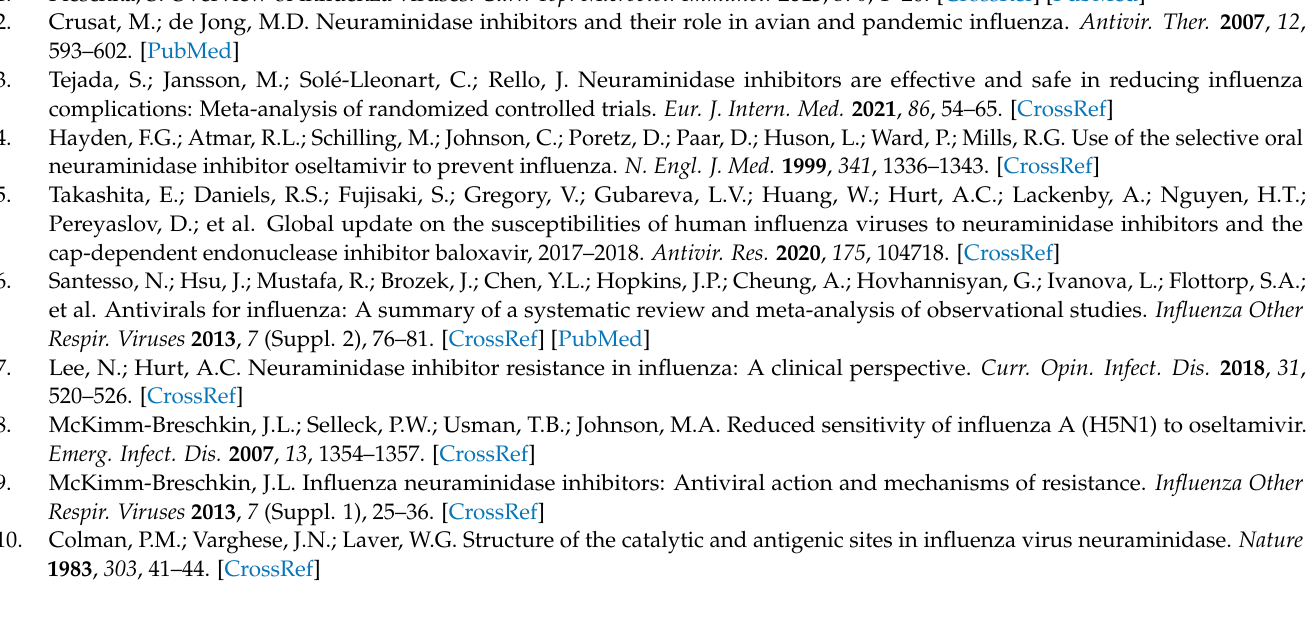
S2: Side-by-side comparison of HEK NA and 3BEQ. Figure S3: 150-cavity of the 8 chains in HEK NA, Figure S4: Active site and 150-cavity of selected NA structures, Figure S5: NA glycosylations at Asn88, Figure S6: NA glycosylations at Asn146, Figure S7: NA glycosylations at